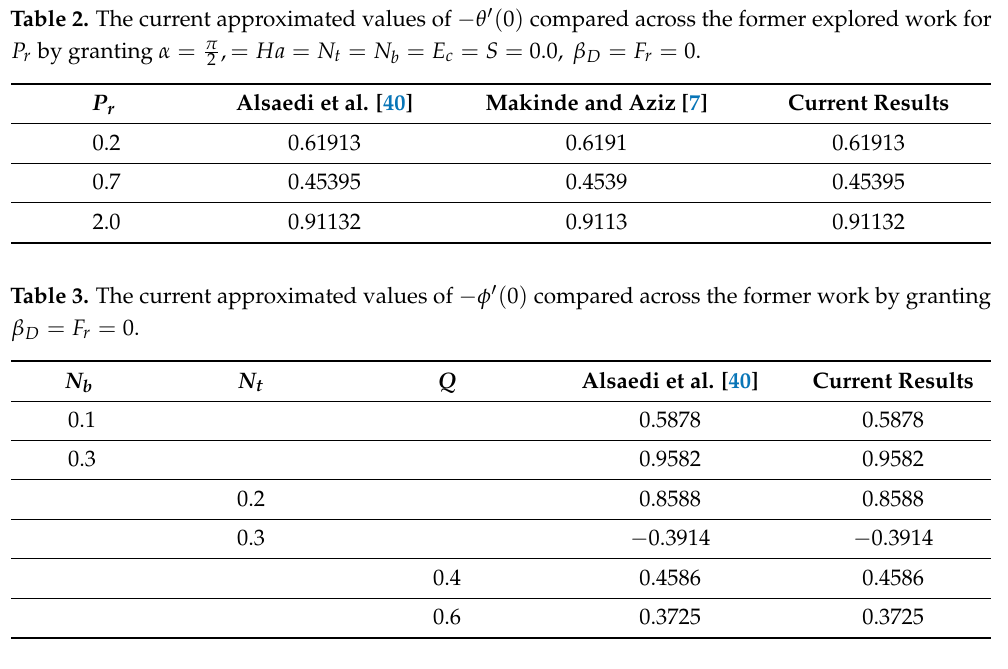
Table 2. The current approximated values of − θ (cid:48) ( 0 ) compared across the former explored work for